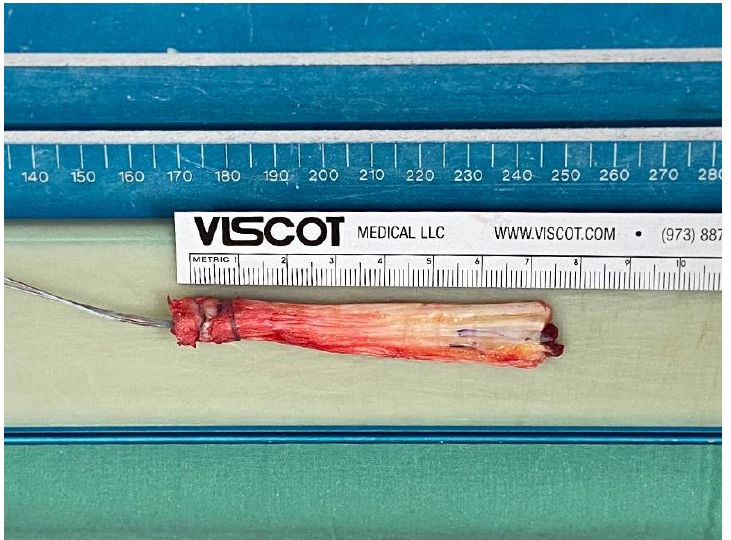
Figure 1. All soft tissue quadriceps tendon autograft immediately after harvesting.